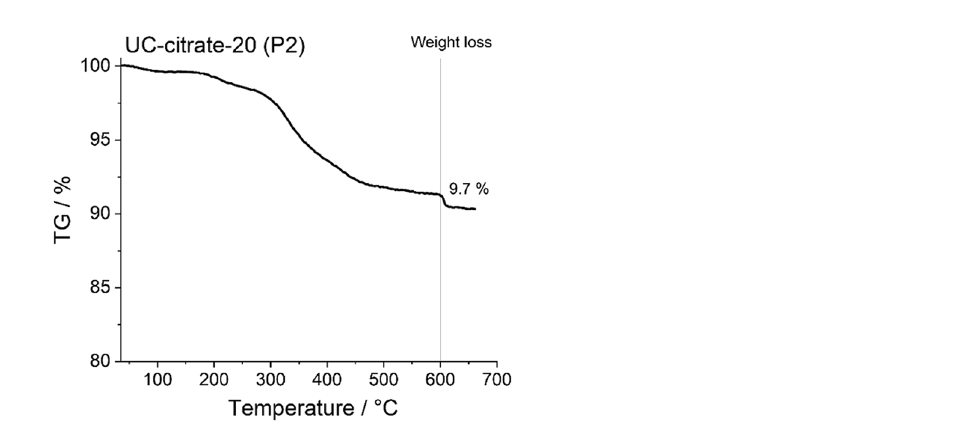
Figure 8. Thermogravimetric analysis (TGA) curves of 21.5 nm-sized NaYF4:Yb,Er particles with citrate coating (procedure